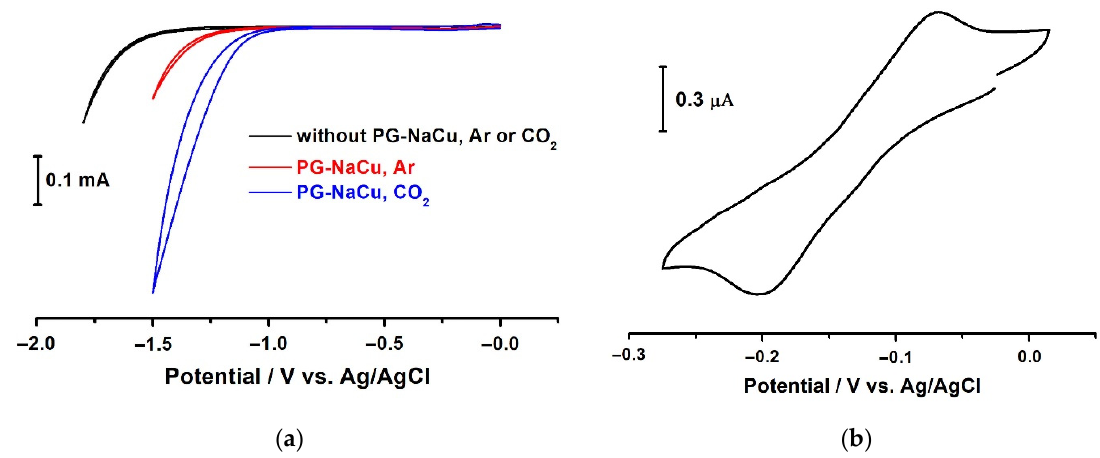
Figure 7. ( a ) CVs recorded at a glassy carbon electrode (GCE) in the presence of the PG-NaCu complex when bubbling argon (red curve) or carbon dioxide (blue curve) through the H 2 O solution, 0.1 V/s. Black line is background in the absence of PG-NaCu, ( b ) CV recorded at a glassy carbon electrode (GCE) in the presence of the PG-NaCu complex when bubbling argon through the H 2 O solution, 0.1 V/s.